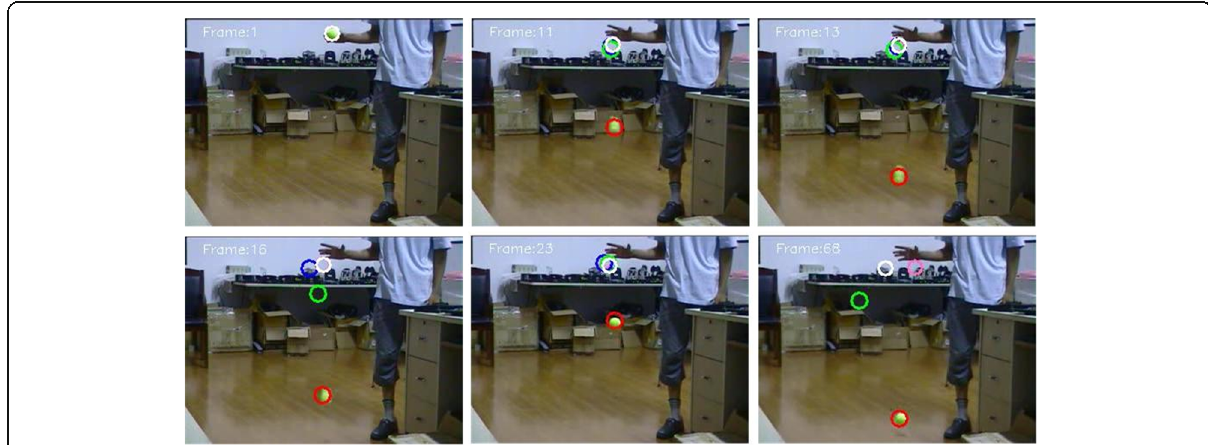
Fig. 16 The tracking results for the video “ tennis ” using CAM-Shift (white), PF (blue), VAPF (green), M-PF (pink), and the proposed tracker (red). Particle number N =